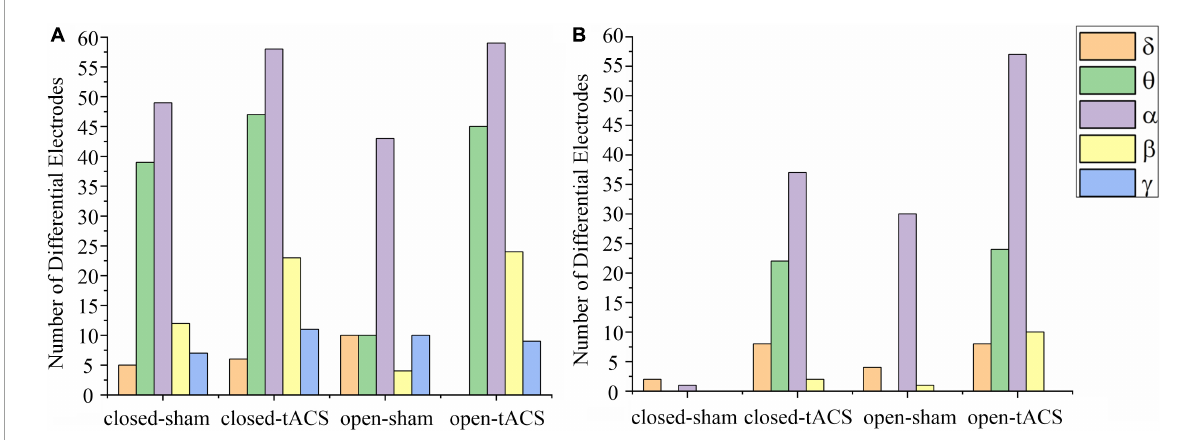
FIGURE2 The number of electrodes has a significant difference between pre-and post-stimulation within different frequency bands under each experimental condition. (A) The stimulation intensity was 1 mA. (B) The stimulation intensity was 2 mA. The number of significantly different electrodes at the blank position is zero. Closed-sham, under the sham stimulation in the eyes-closed state; closed-tACS, under the tACS in the eyes-closed state; open-sham, under the sham stimulation in the eyes-open state; open-tACS, under the tACS in the eyes-open state.